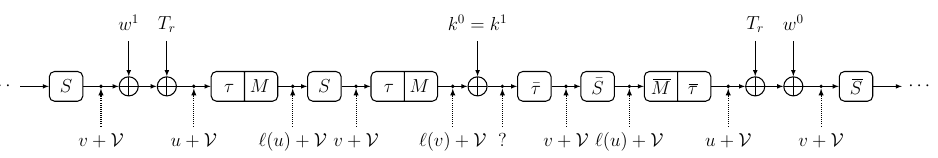
Figure 10: Propagation of Invariant Subspace Cosets Through the Central Construction is akin to that of PRINCE and MANTIS , whose equation systems are slightly smaller. The situation is very different for QARMA -128, where the system is significantly larger than AES -128’s – and in fact even larger than the system for AES -256 – implying that QARMA -128 should offer much better resistance against algebraic